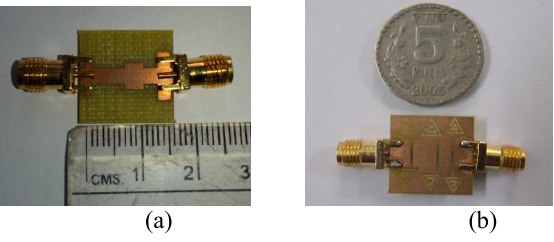
Fig. 4: Fabricated layout of proposed microstrip low pass filter with triangular CSRR-DGS: (a) top